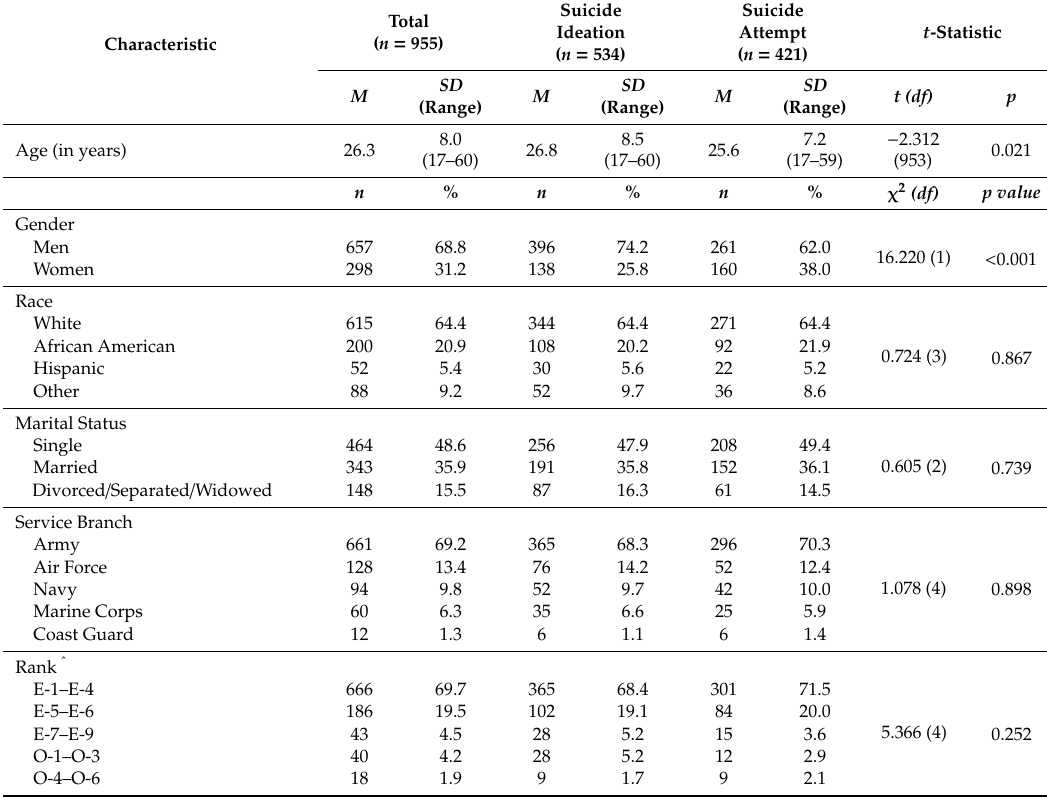
Table 1. Demographic characteristics across military psychiatric inpatients hospitalized for suicide attempt versus suicide ideation ( n =